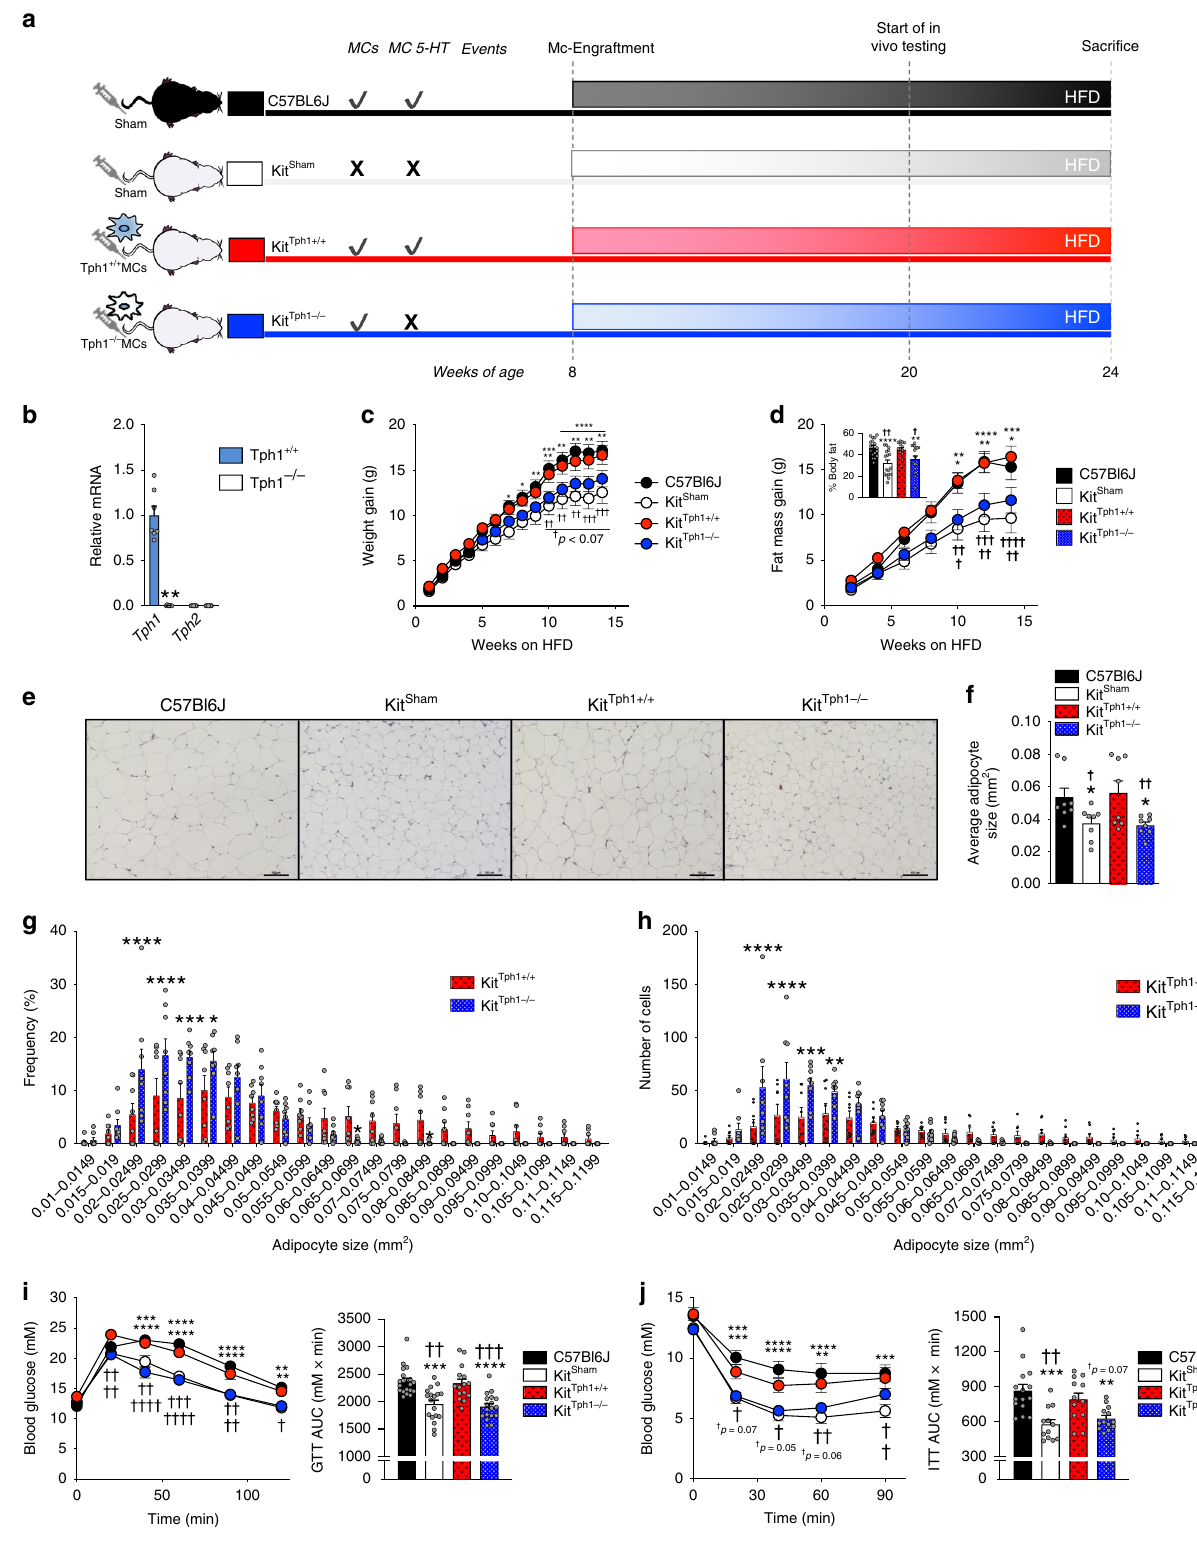
improved glucose tolerance (Fig. 2i) and insulin sensitivity (Fig. 2j) compared to controls. Importantly, these differences in metabolism between Kit Tph1 + / + and Kit Tph1 − / − mice were not due to differences in the number of mast cells within iWAT and gWAT, which were comparable between genotypes (Supplemen- tary Fig. 2g,